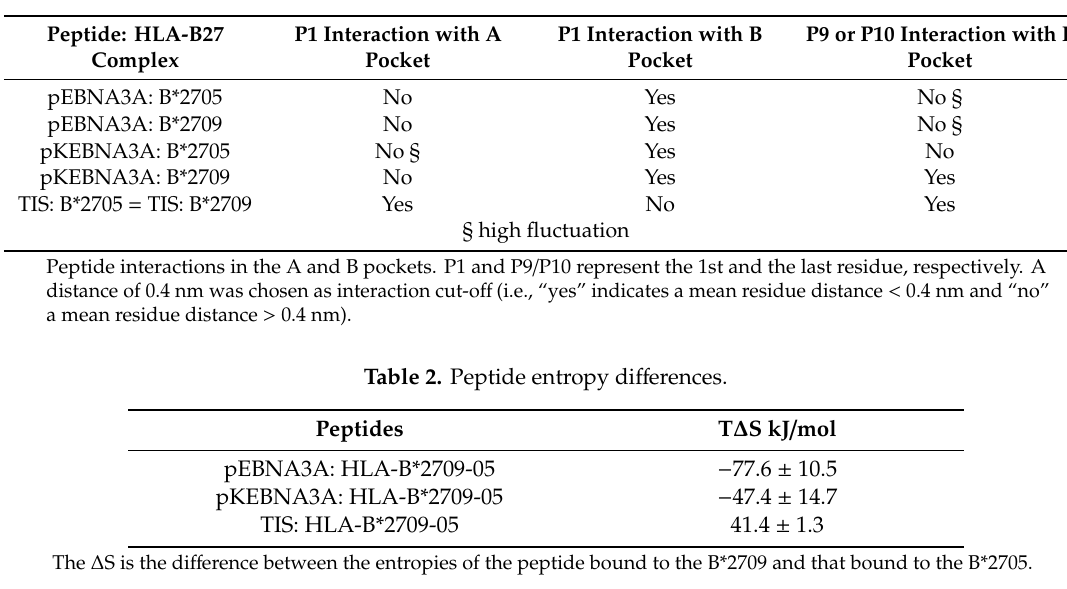
Figure 3. Representative snapshots as obtained by MD simulations of the peptide:HLA-B27 complexes. The upper panels show HLA-B*2705 in complex with pEBNA3A (blue), pKEBNA3A (magenta), TIS (orange) peptides. The bottom panels show the peptide:HLA-B*2709 complexes. A (green), B (yellow) and F (pink) pockets are indicated. Table 1. Peptide position in the binding groove.